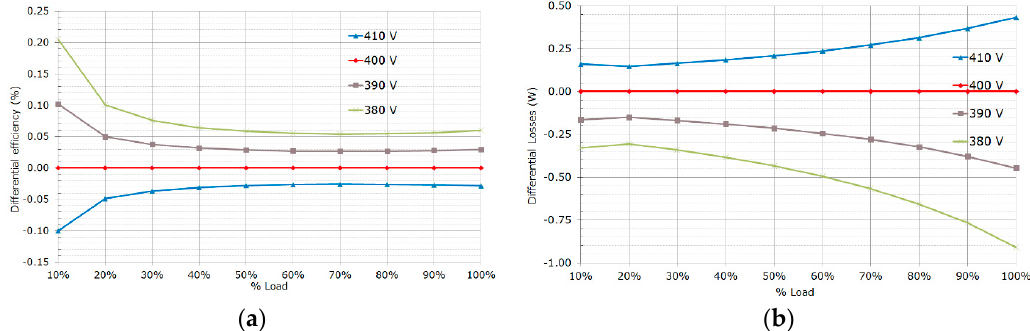
Figure 18. Performance comparison for different nominal input voltages: ( a ) differential efficiency; ( b ) differential losses.